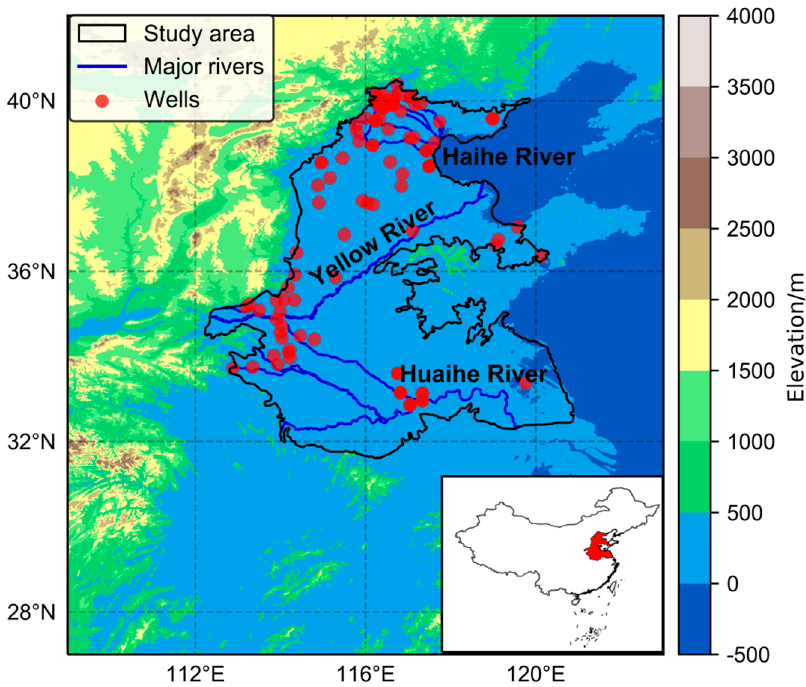
Figure 1. Study area of the Huang-Huai-Hai Plain (3H Plain, surrounded by the black curve) and the distribution of groundwater monitoring wells (red dots). The main rivers are shown in blue. The insert map shows the location of the 3H Plain in China.